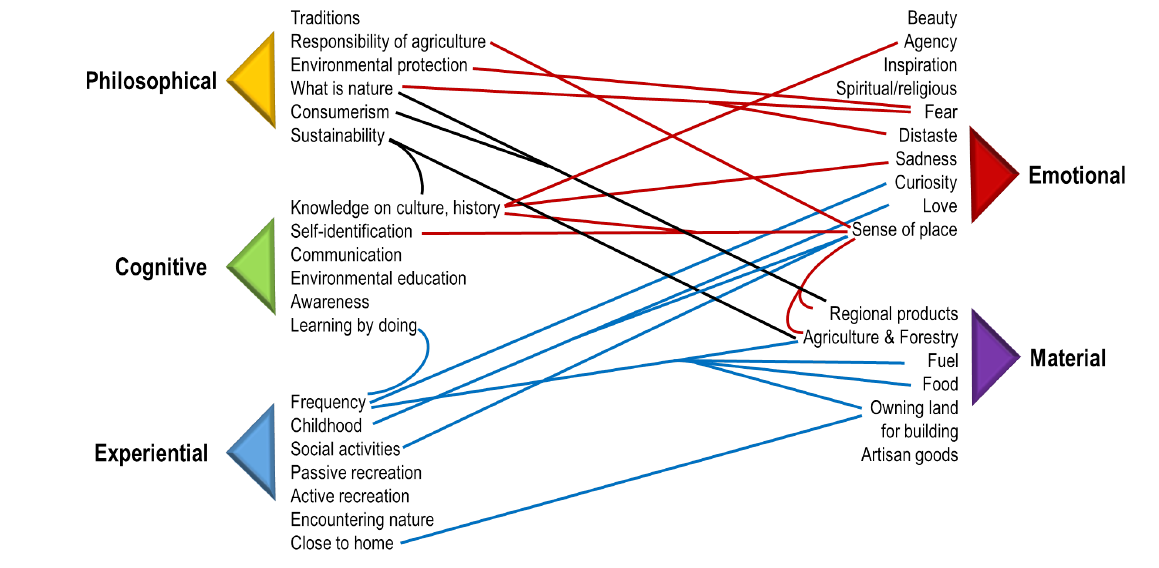
Fig. 2. Graphical representation of relationships among the five dimension of human–nature connectedness (material, experiential, cognitive, emotional, and philosophical; from Ives et al. 2018) based on the content analysis of four focal areas (see details in Table 1). Lines indicate relationships between the categories of human–nature connectedness as highlighted by the interviewees. For ease of interpretation, lines from experiential and emotional connections are shown in blue and red,